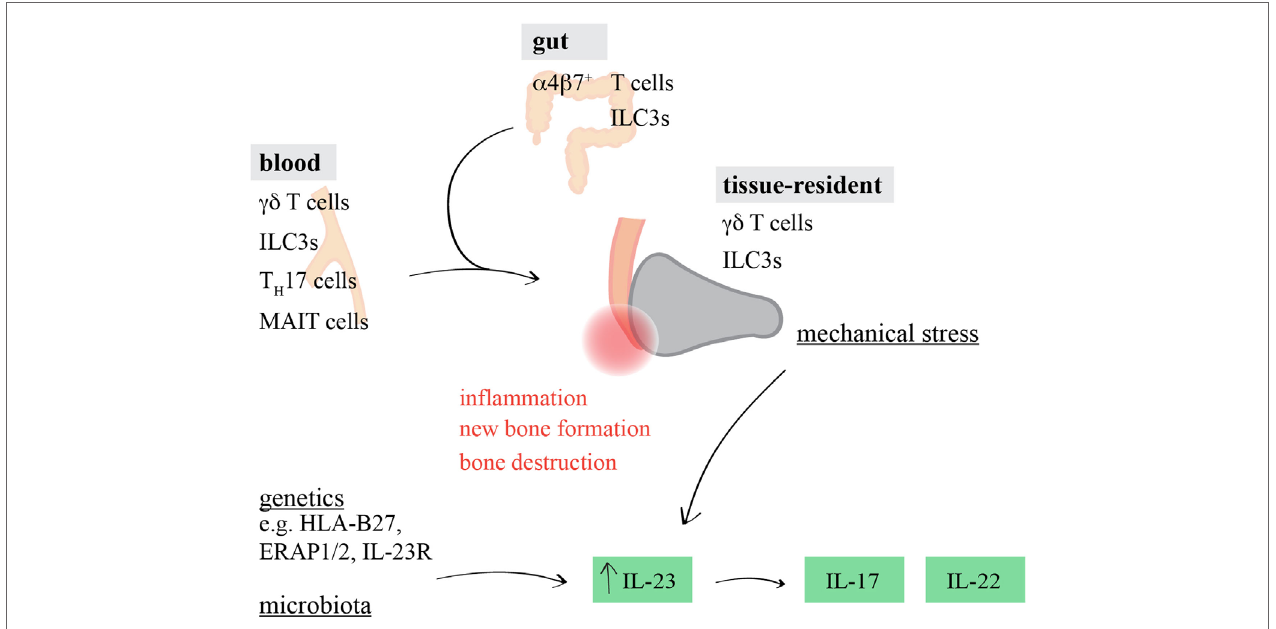
FigURe 1 | Involvement of interleukin (IL)-17/IL-22-producing lymphocytes in spondyloarthritis (SpA)-associated inflammation. Genetic and epigenetic predisposition, altered microbial composition, and entheseal microdamage can influence the induction and progression of tissue inflammation in SpA. In addition to tissue-resident γδ T cells and ILC3s, circulating and/or gut-derived γδ T cells, ILC3s, T H 17 cells, or mucosal-associated invariant T (MAIT) cells might promote IL-23-driven joint inflammation by producing increased amounts of IL-17 and